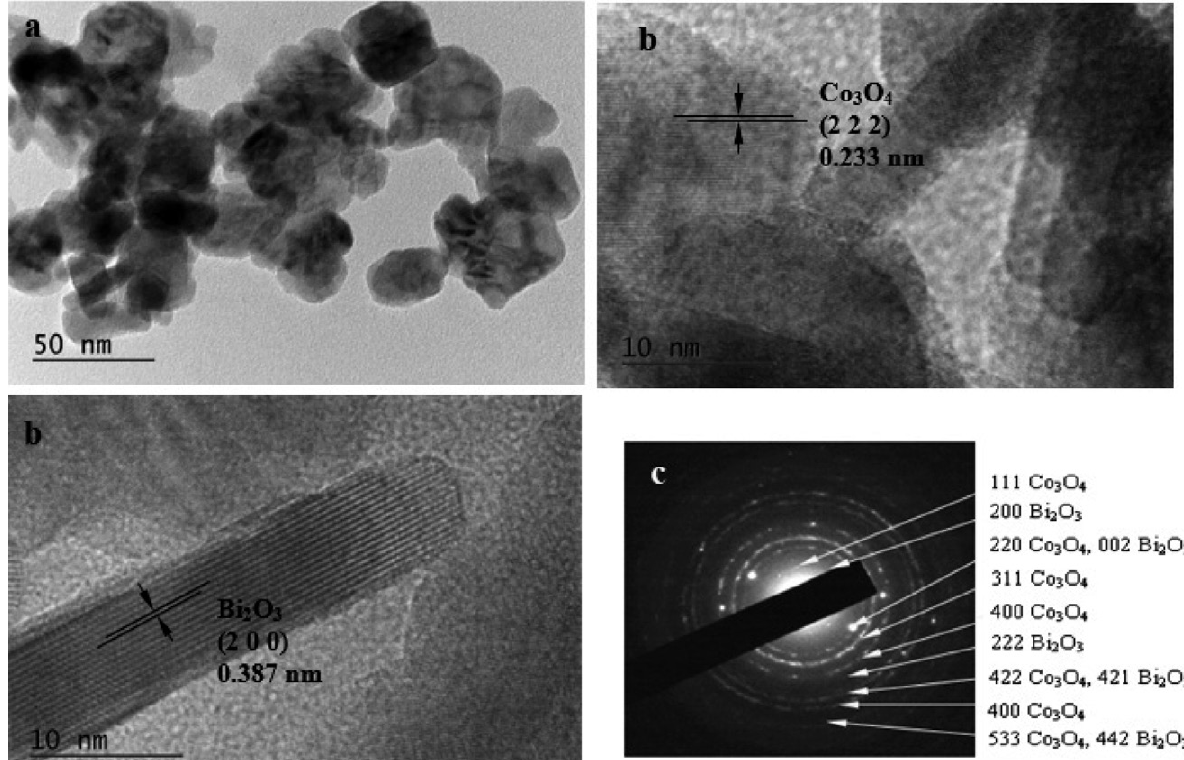
Fig. 2. (a) Bright-field TEM image, (b) HRTEM images and (c) SAED pattern of 50% Bi 2 O 3 -Co 3 O 4